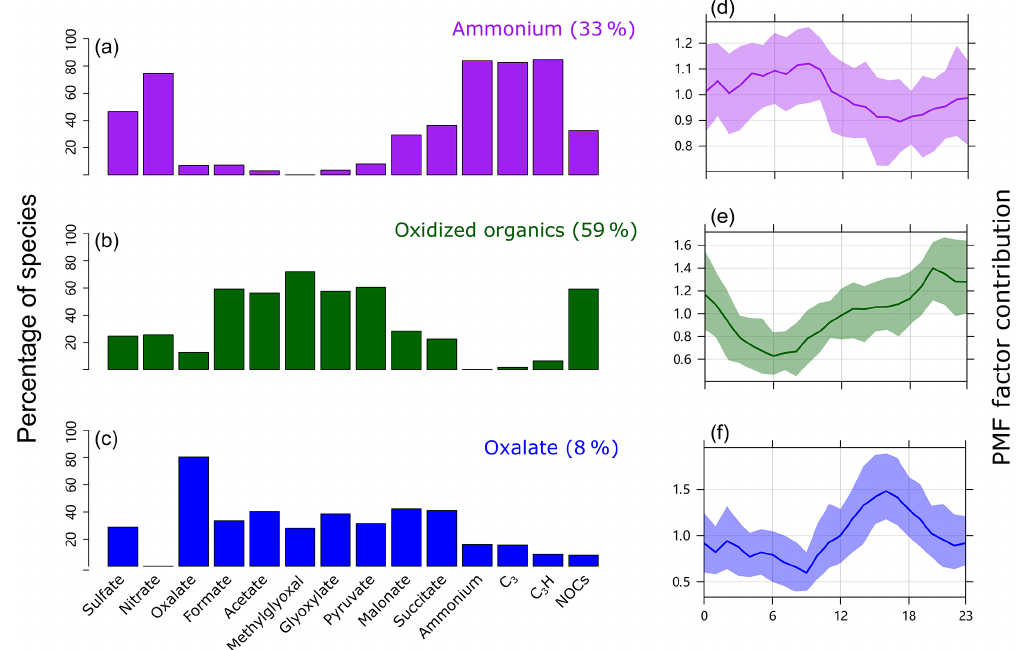
Figure 5. (a, b, c) PMF-resolved three-factor source profiles (percentage of total species) and (d, e, f) their diurnal variations (arbitrary